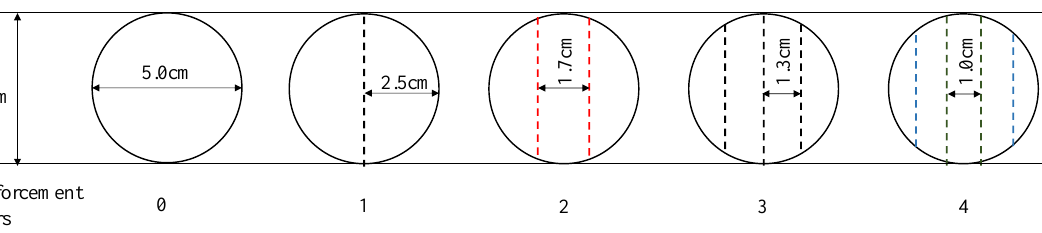
Figure 3. Laying method of the reinforcement belt in the reinforced tailings dam.